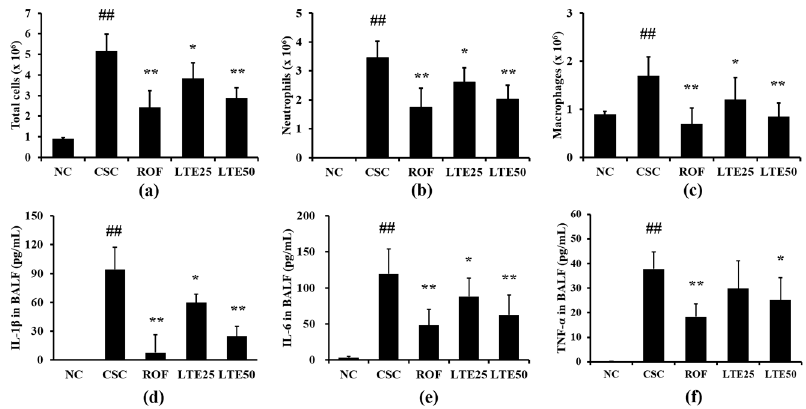
Figure 8. Effects of LTE on pathophysiological factors in CSC+LPS exposed mice. ( a ) Total cells in BALF, ( b ) neutrophils in BALF, ( c ) macrophages in BALF, ( d ) IL-1 β levels in BALF, ( e ) IL-6 levels in BALF, and ( f ) TNF- α levels in BALF. ## , vs. NC, p < 0.01, *, **, vs. CSC+LPS, p < 0.05 and <0.01, respectively.